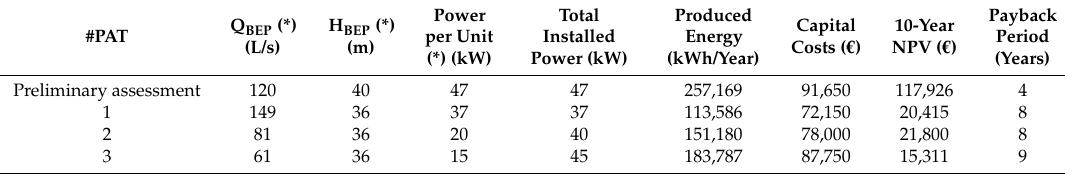
Figure 7. Daily recoverable energy if ( a ) one PAT; ( b ) two PAT and ( c ) three PAT are installed in parallel. Table 1. Optimal operating head and flow, produced power and expected annual energy production.